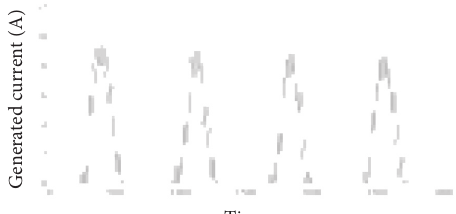
Figure 24: Generated current at the node.